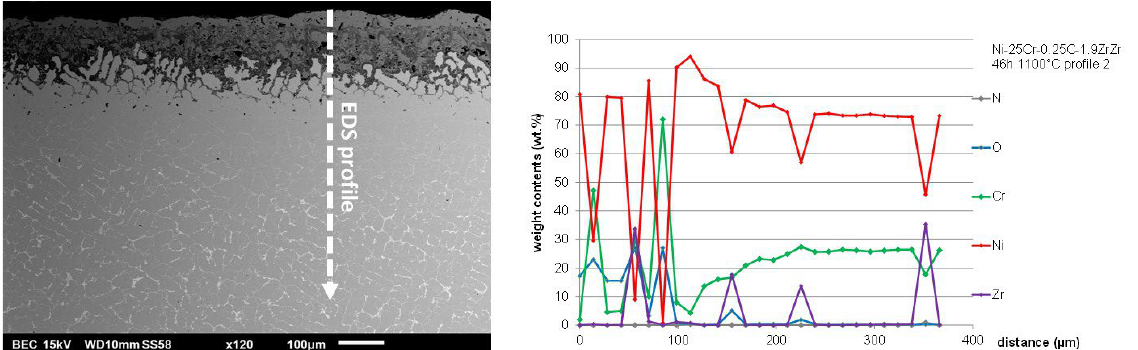
Figure 10. Low magnification SEM/BSE view of the external oxide scale and of the subsurface of the Ni–25Cr–0.25C–1.9Zr alloy ( left ) and EDS concentration profile acquired over the depth, represented by a dotted white arrow in this SEM/BSE micrograph ( right ).